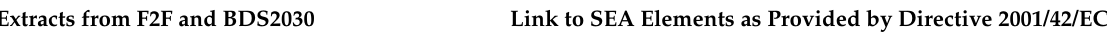
Table 1. Links between the Farm to Fork and Biodiversity Strategies and SEA elements as provided by Directive 2001/42/EC. Source: authors’